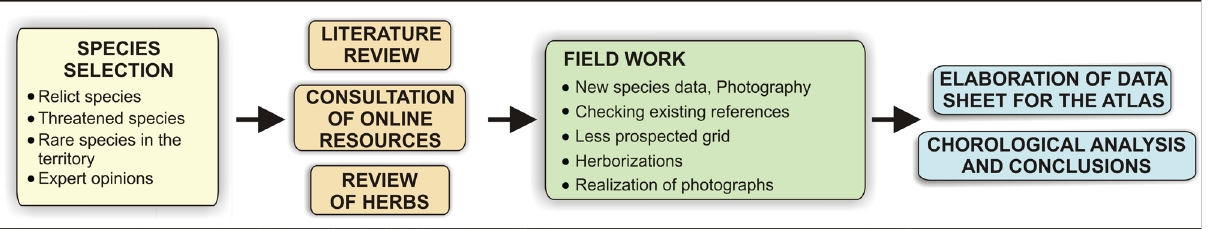
Figure 2. Methodological